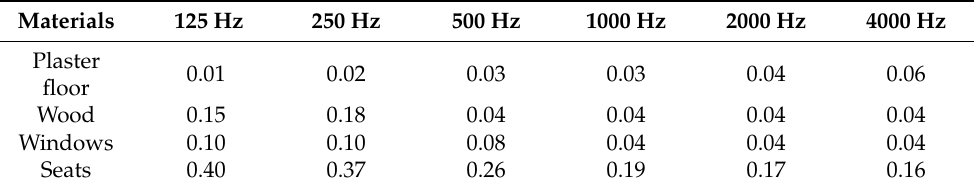
Figure 15. Exterior ( left ) and interior ( right ) view of the acoustic treatment virtually introduced into the CAD model. The ceiling-mounted MPPs are highlighted in red. Table 5. Calibration setup (without MPP): random incidence absorption coefficients used in geo- metrical acoustics (GA) simulations and considered in the backward optimization process to obtain the acoustic admittances for the finite-difference time-domain (FDTD) simulation. The macro-layers used in the present work divide the materials into: hard/reflective surfaces (plaster floor), elements absorbing slightly at low frequencies (wood, windows) and the most sound absorbing area (seats).